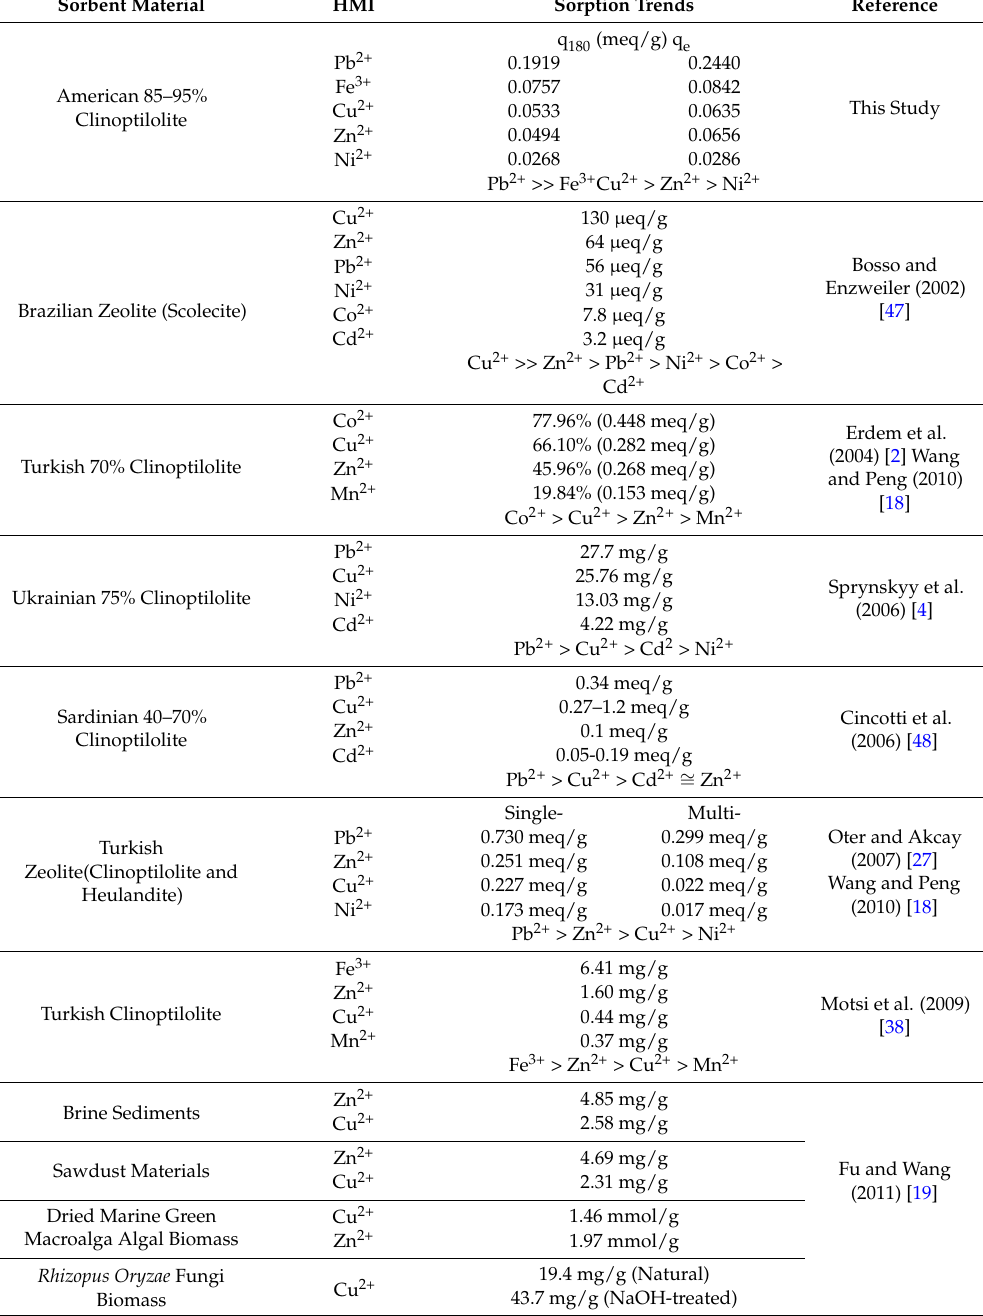
Table 7. The sorption trends of heavy metallic ions on various sorbent